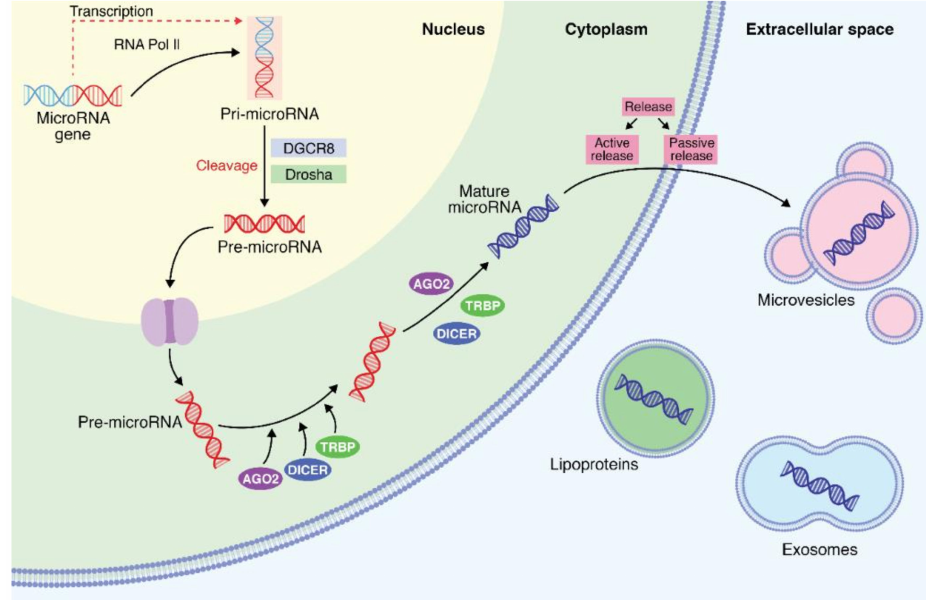
Figure 1. MicroRNA biosynthesis mechanisms. For further explanation, please see the details in the text. RNA pol II—RNA polymerase II; pri-microRNA—primitive microRNA; DGCR8—DiGeorge Syndrome Critical Region 8; Drosha—RNAse III endonuclease; pre-microRNA—precursor of microRNA; AGO2—endonuclease Argonaute 2; Dicer—Rnase III endonuclease; TRBP—transactivation response element RNA-binding